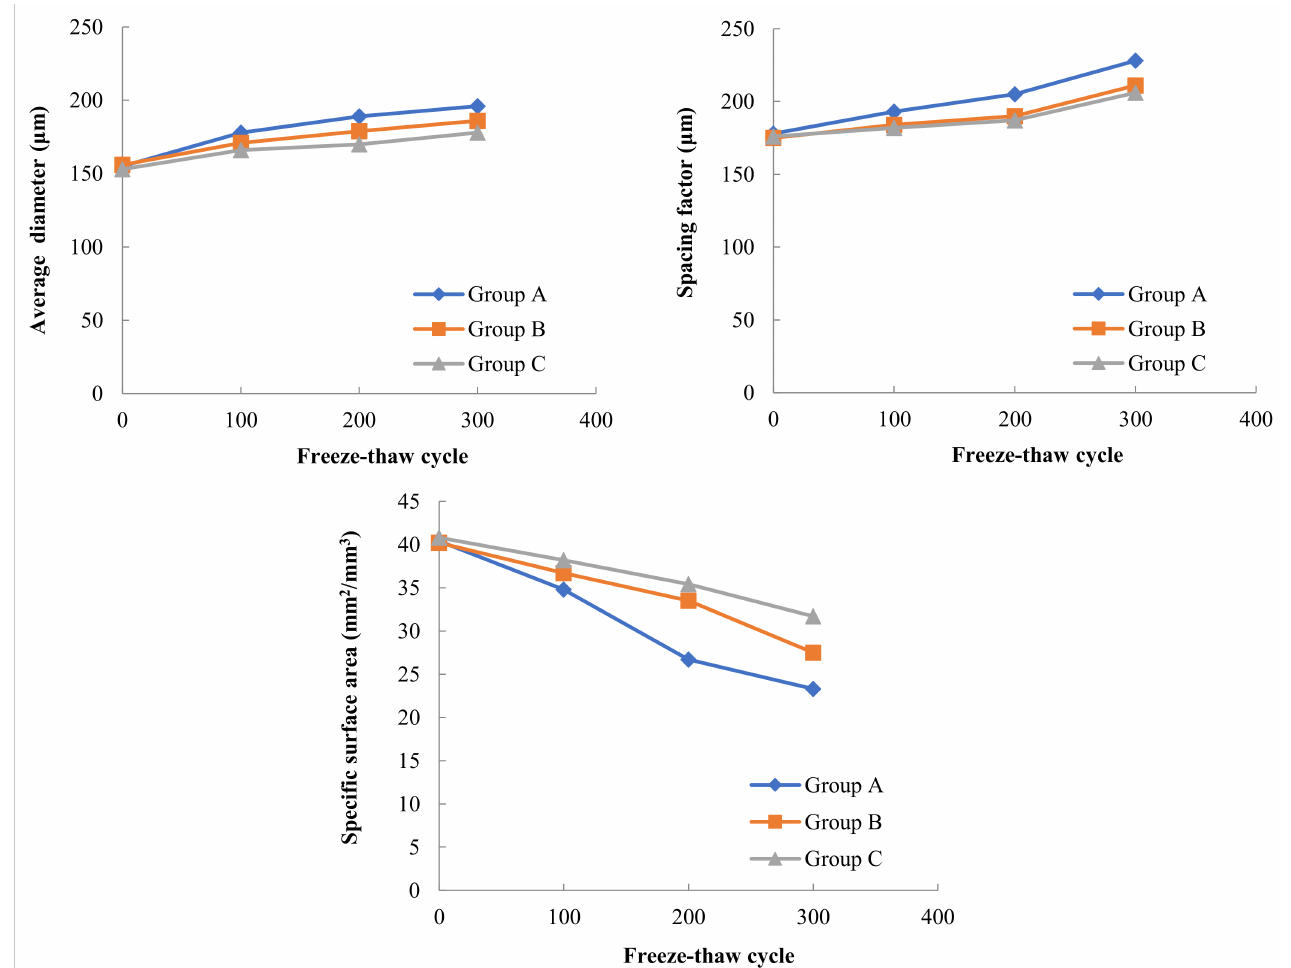
Figure 9. Variation of air void parameters for concrete with different internal water content ( − 30 ◦ C freezing